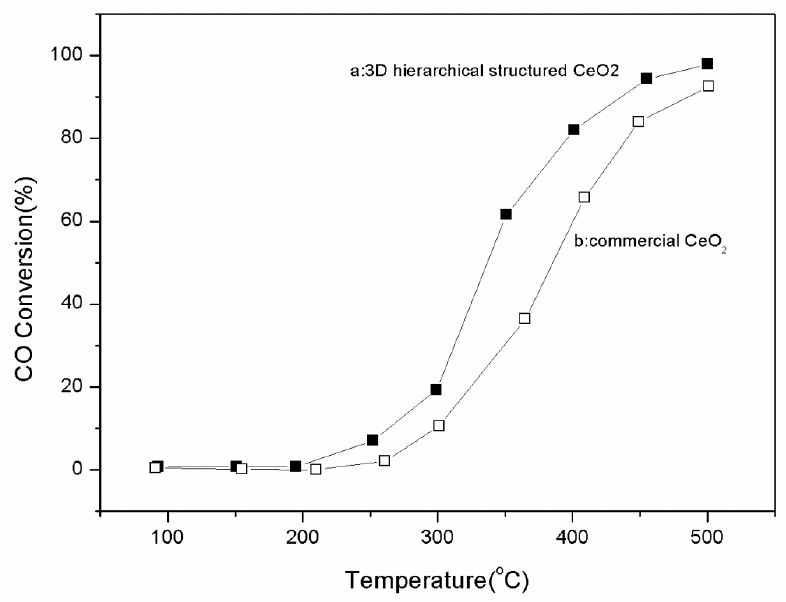
Figure 6. CO conversion rate in the presence of ( a ) as-prepared 3D hierarchical structured CeO 2 , and ( b ) commercial CeO 2 .